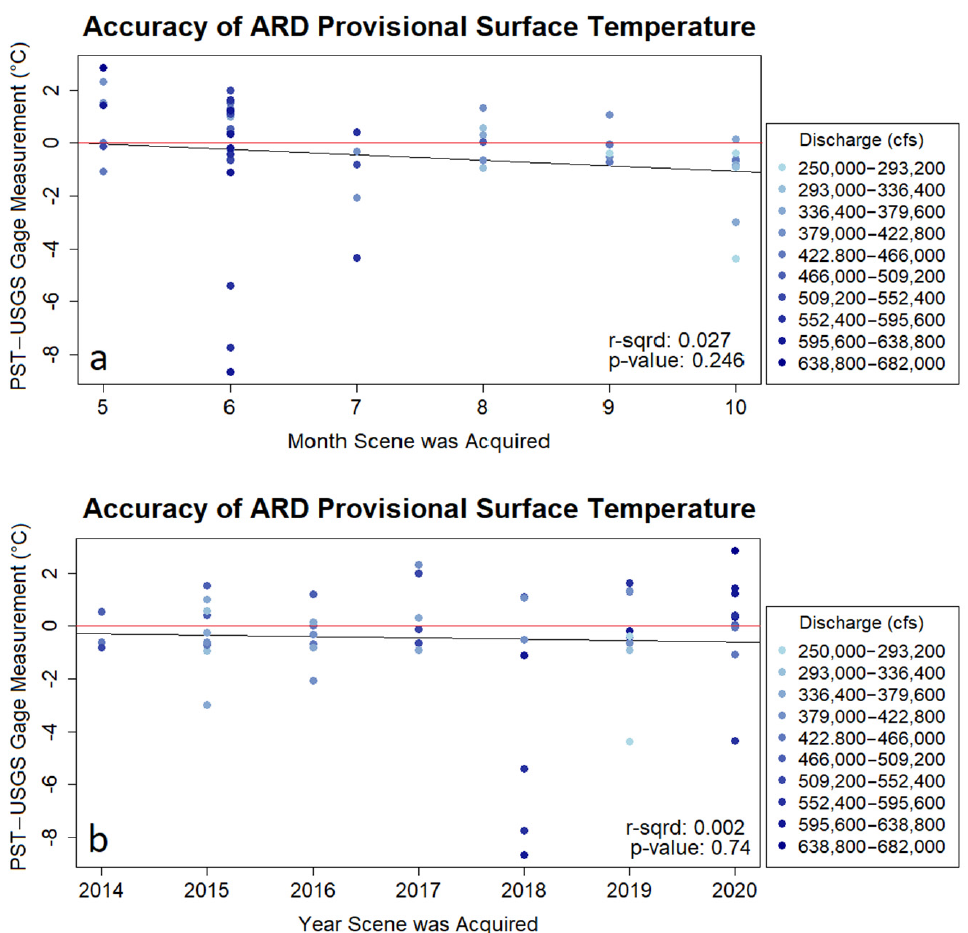
Figure 7. Scatter plots showing how the attributes of ( a ) month of acquisition and ( b ) year of acquisition can influence the agreement between the estimated and observed water temperature. Data points are color-coded according to river discharge.